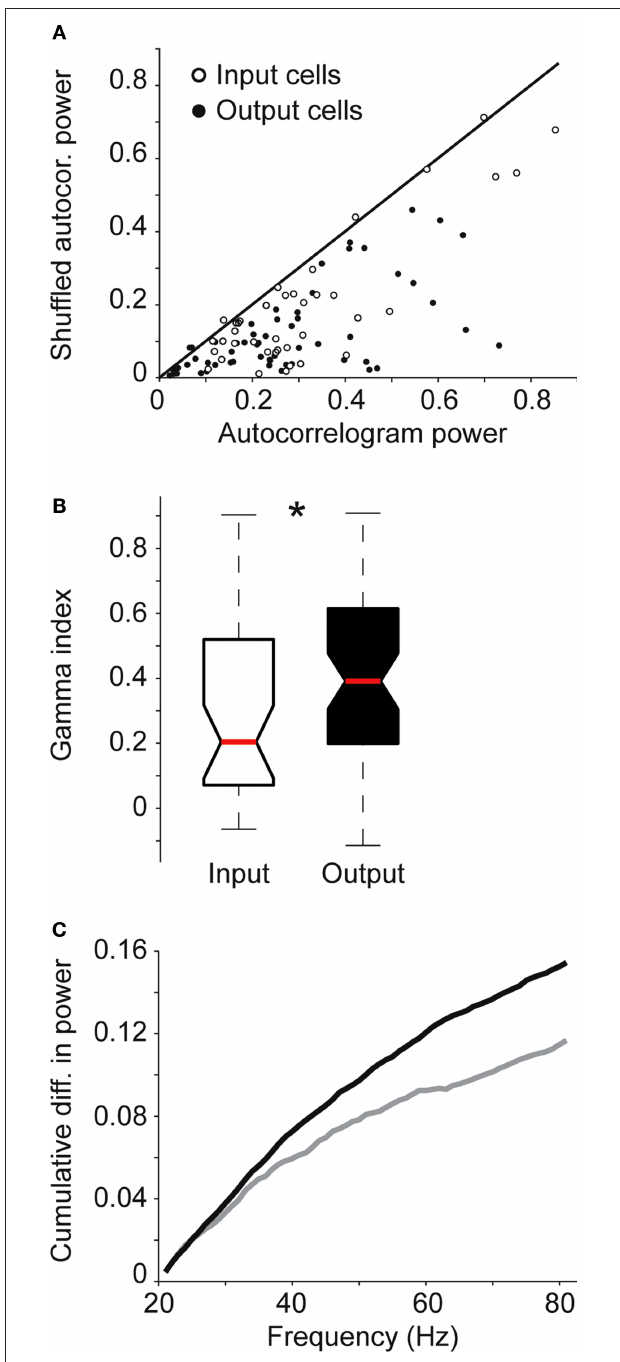
FIGURE 3 | Relative power in the gamma-band for input and output neurons. (A) Comparison of integrals of power in the gamma-band (20–80 Hz) from autocorrelogram and shuffl e correlogram data for the sample of input (open circles) and output (fi lled circles) neurons. (B) Relative gamma-band activity index for input (open box) and output (black box) neurons. Red bars represent medians. Asterisk indicates that gamma-band indices for output neurons were signifi cantly greater than those for input neurons ( p = 0.02, Rank sum test). (C) Cumulative plots of the difference between integral values from power spectra in the gamma range from population-averaged autocorrelogram and shuffl e correlograms for input (grey) and output (black)